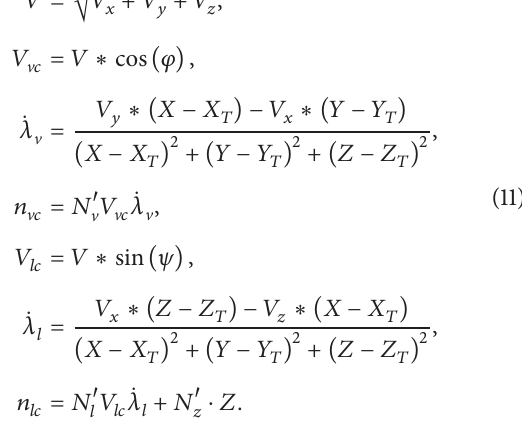
Figure 13: Trajectory